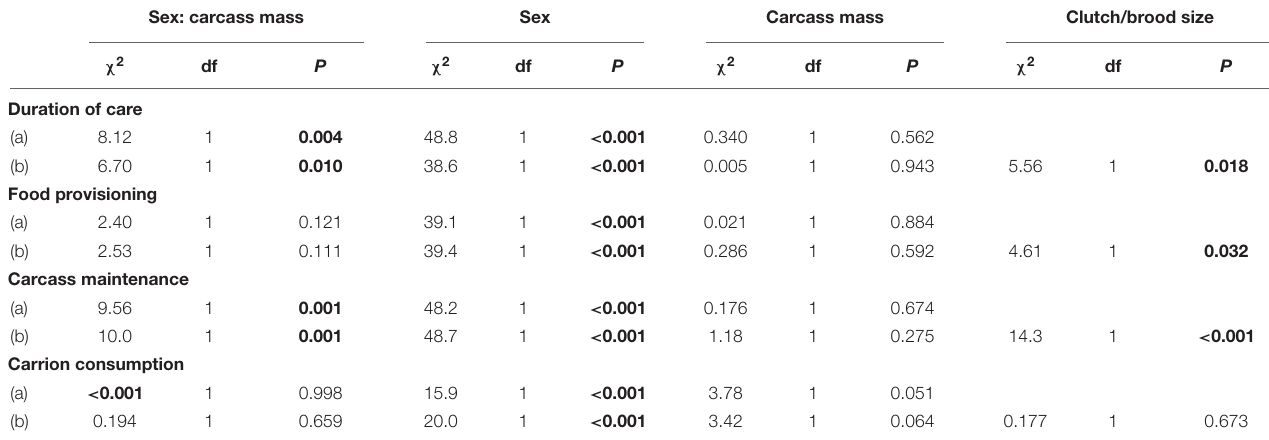
TABLE 1 | Effects of the interaction between sex of the focal parent and carcass mass on the duration of uniparental care when clutch size excluded (a) and included (b). Effects of the interaction between sex of the focal parent and carcass mass on time spent provisioning food to the brood, maintaining the carcass and consuming carrion when brood size at the time of observation was excluded (a) and included